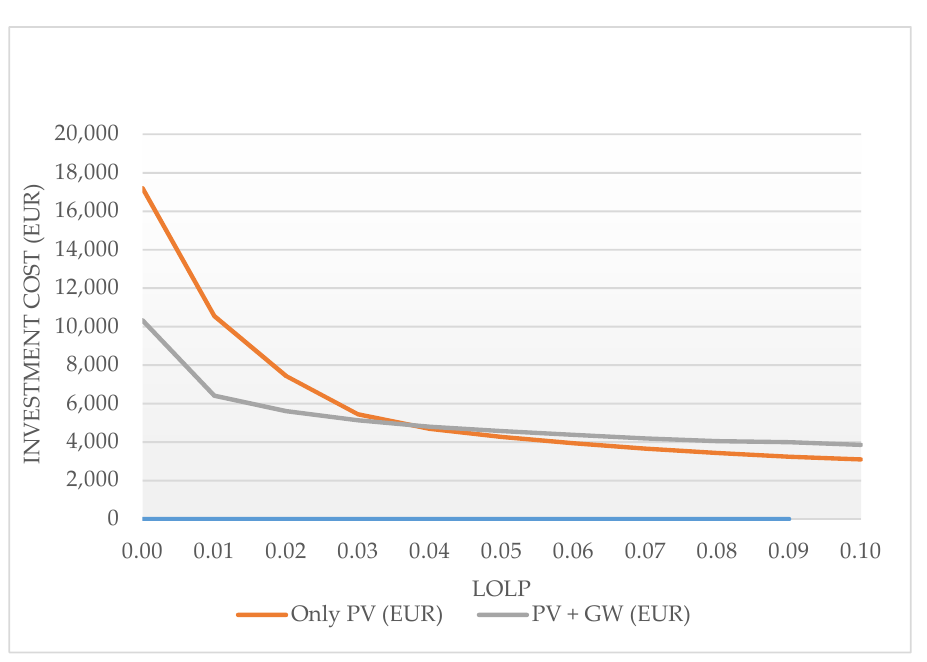
Figure 5. Investment cost in respect to LOLP.